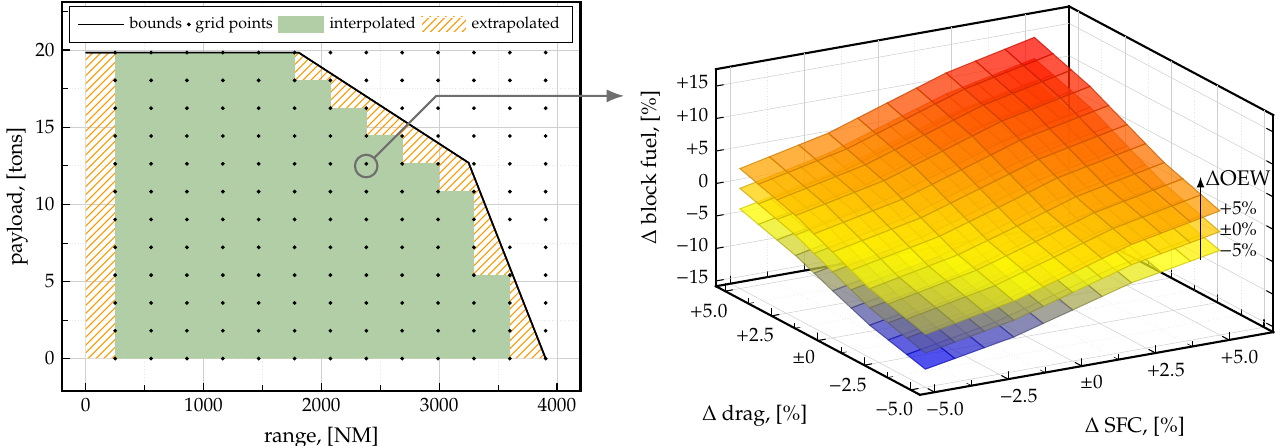
Figure 11. Aircraft performance response surfaces with a payload-range variation ( left ) and the impact of the three technology factors drag, Operating Empty Weight (OEW), and Specific Fuel Consumption (SFC) ( right